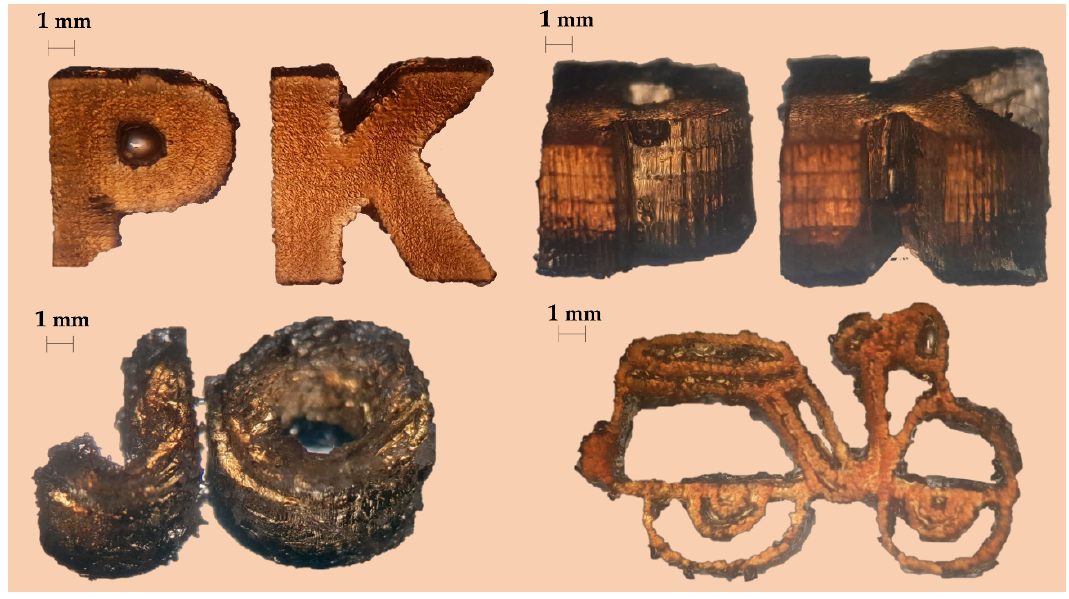
Figure 10. Cationic photopolymerization of glycidyles: DGEBA/EPXPROP (70%/30% w/w) in the presence of biphenyls derivatives/Iod (0.2/2% w/w) for 3D printing.